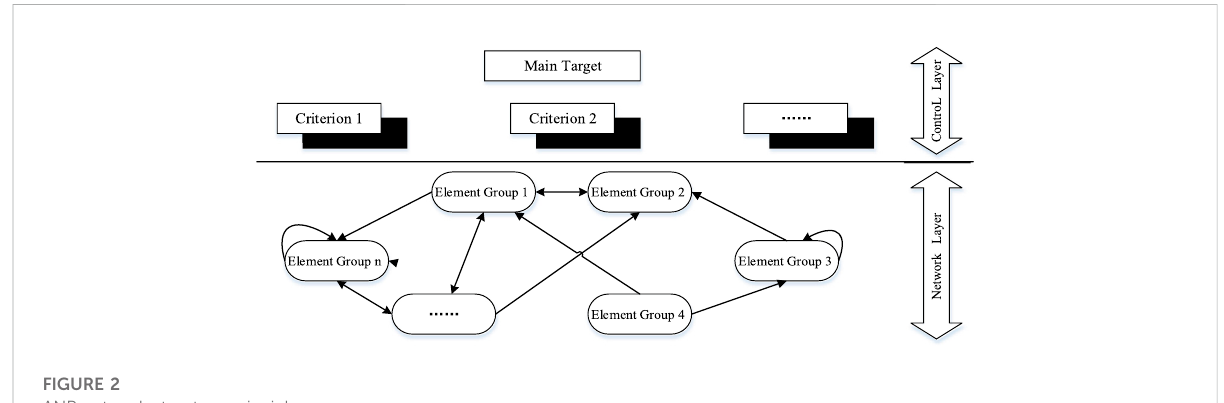
FIGURE 2 ANP network structure